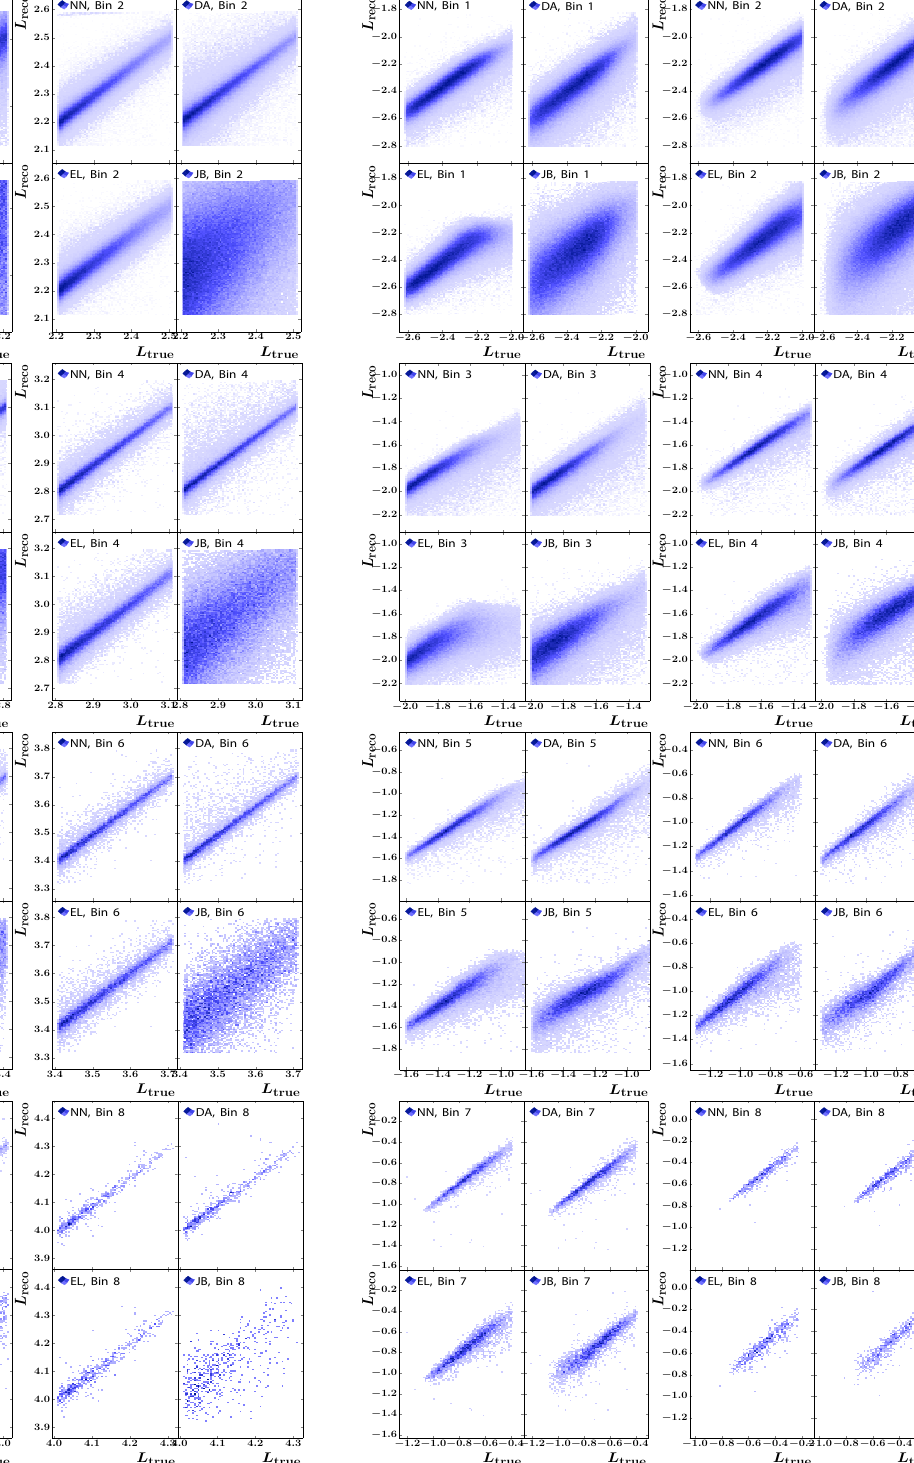
Fig. 8 Distribution of events in L reco = log x versus L true = log x true plane for various reconstruction methods in individual analysis